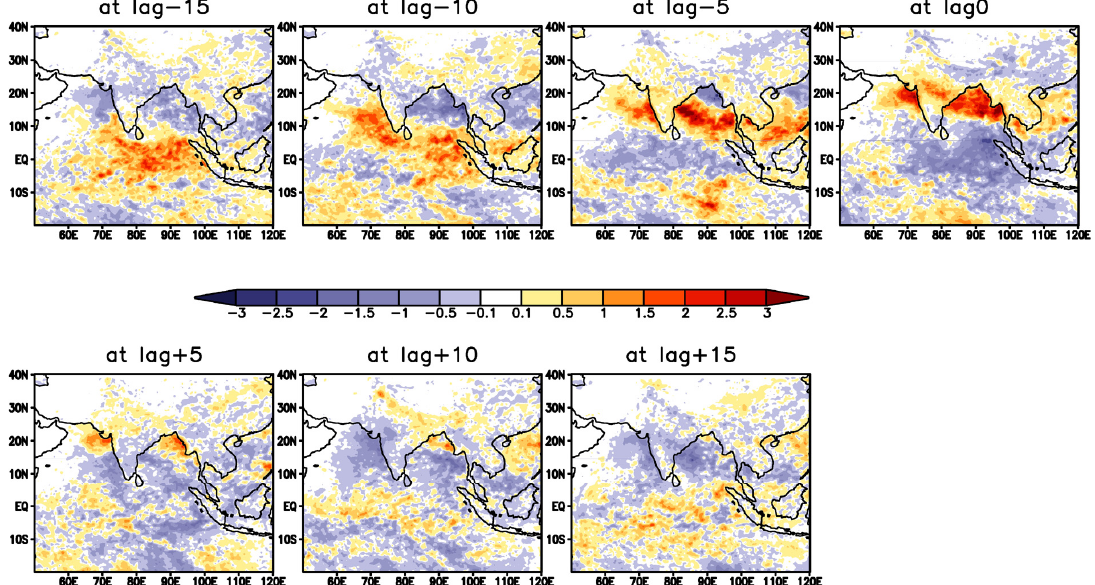
Fig. 4. Lag composite of cloud ice (mgm − 3 day − 1 ) during active spells based on CIPI using TRMM 2A12 data for the period